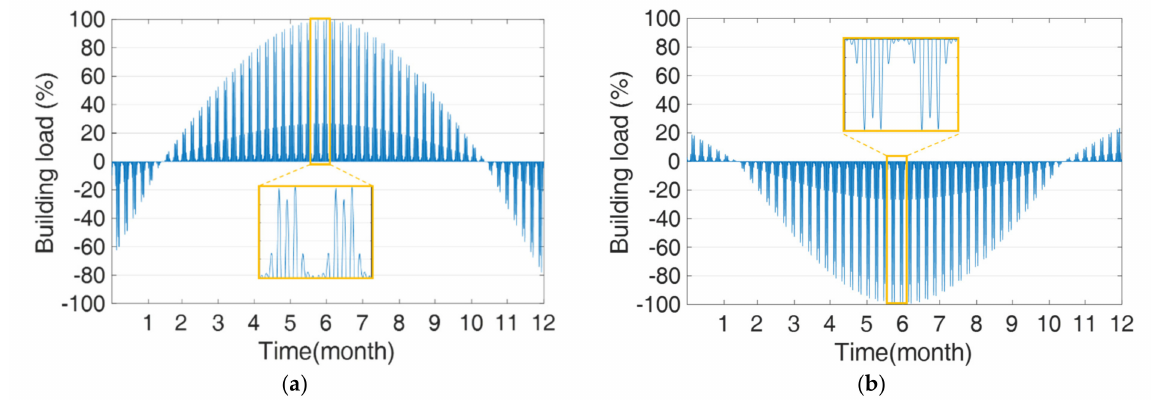
Figure 4. Test building load: ( a ) cooling-dominant case and ( b ) heating-dominant